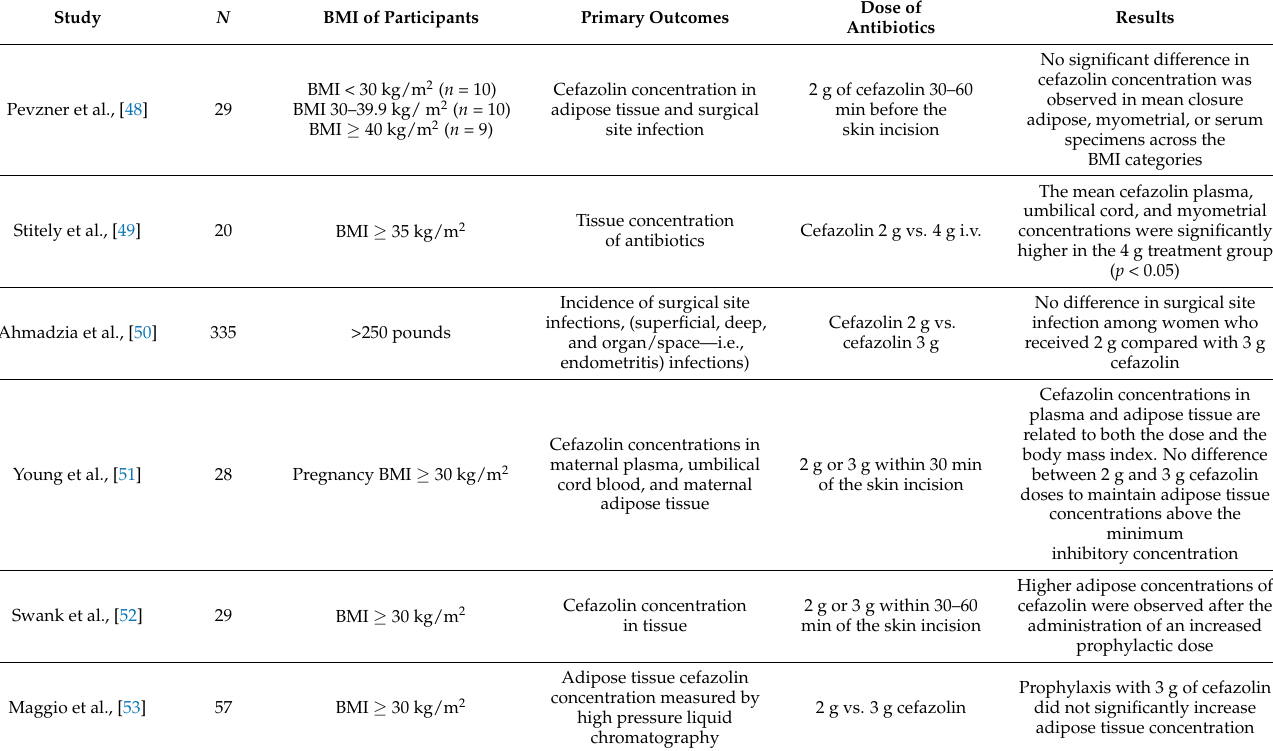
Table 3. Results of studies that included a prophylactic dose of